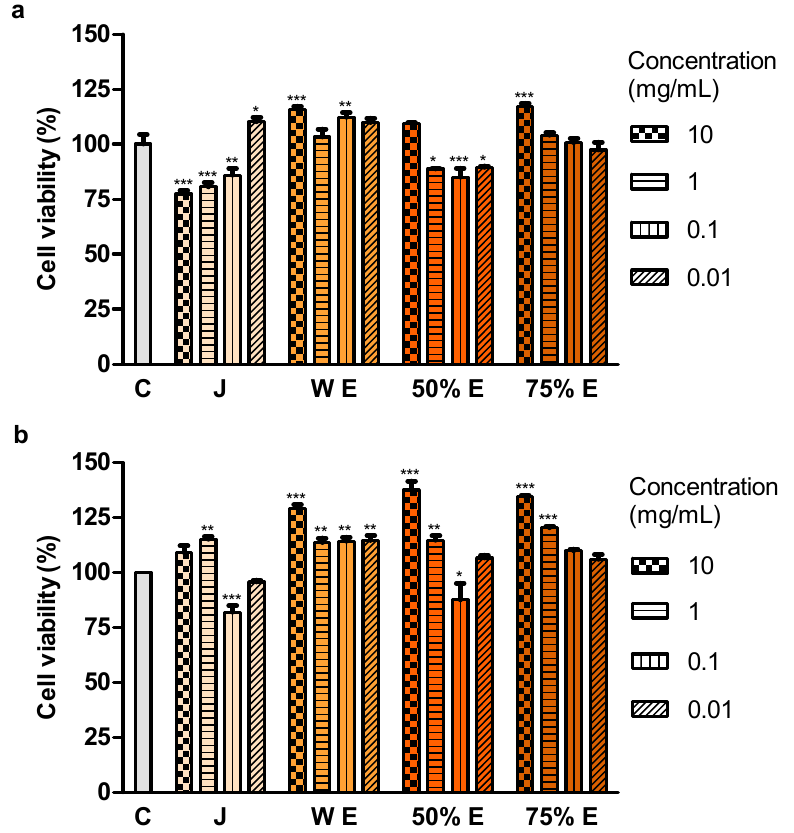
Figure 3. Viability of Caco-2 cells after ( a ) 24 h and ( b ) 72 h of treatment with juice (J), water extract (W E), 50% hydroethanolic extract (50% E) and 75% hydroethanolic extract (75% E) from Saposhnikovia divaricata root, at different concentrations. C—control cells (treated with deionized water). Error bars indicate standard error of the mean. Statistically significant effect: * represents values that differ from control at p < 0.05, ** represents values that differ from control at p < 0.01, *** represents values that differ from control at p < 0.001. n = 5.